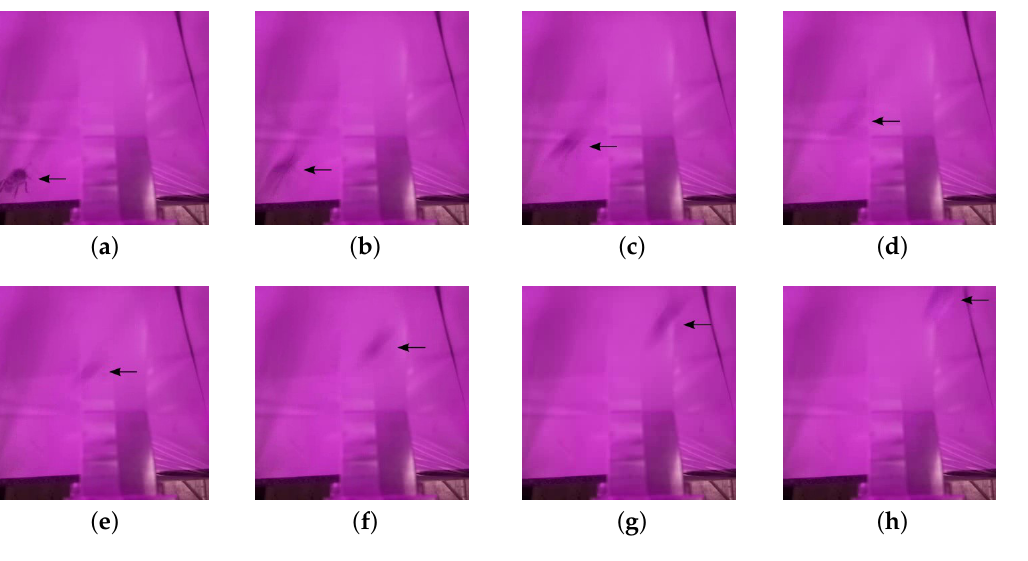
Figure 10. Equidistant time series of video frames captured during a bee measurement. The corre- sponding measurement results are shown in Figure 9a,b. ( a ) t = 0.185 s. ( b ) t = 0.218 s. ( c ) t = 0.252 s. ( d ) t = 0.285 s. ( e ) t = 0.318 s. ( f ) t = 0.352 s. ( g ) t = 0.385 s. ( h ) t = 0.418